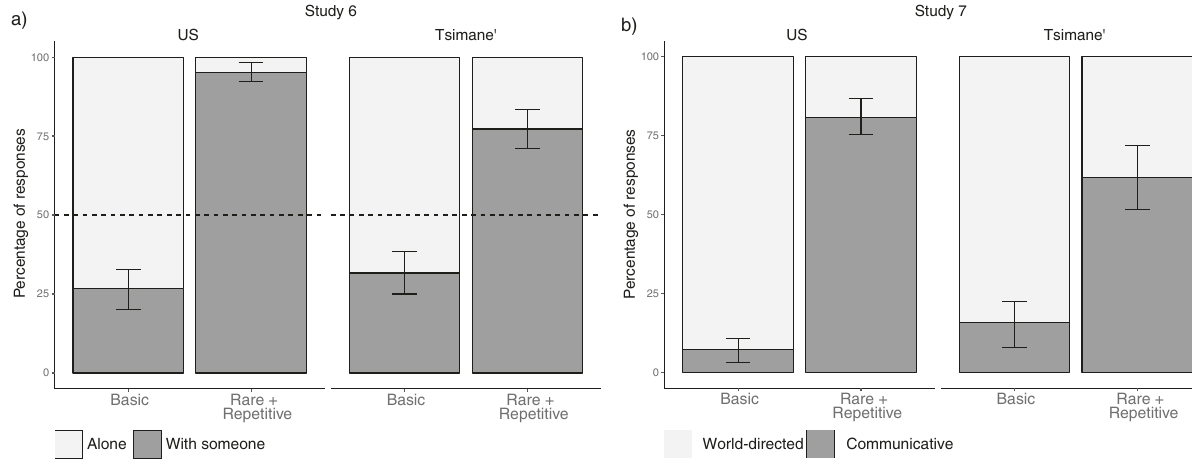
Fig. 7 Results from Studies 6 and 7. Vertical lines represent 95% bootstrapped con fi dence intervals. a Average percentage of trials in Study 6 where US ( n = 59) and Tsimane ’ ( n = 59) participants judged that the actor was alone or with someone as a function of the type of video they watched. Participants were more likely to judge that the actor was alone when watching a basic movement, and more likely to infer the presence of another agent when watching a rare + repetitive movement. b Average percentage of world-directed and communicative explanations that US ( n = 100) and Tsimane ’ ( n = 32) participants produced as a function of video type (Study 7). Results are normalized after excluding explanations coded as descriptive or other (see SI). Participants were more likely to produce a world-directed explanation when watching a basic movement, and signi fi cantly more likely to produce a communicative one when watching a rare + repetitive one (this result does not depend on the pre-registered exclusion of descriptive and other explanations; see